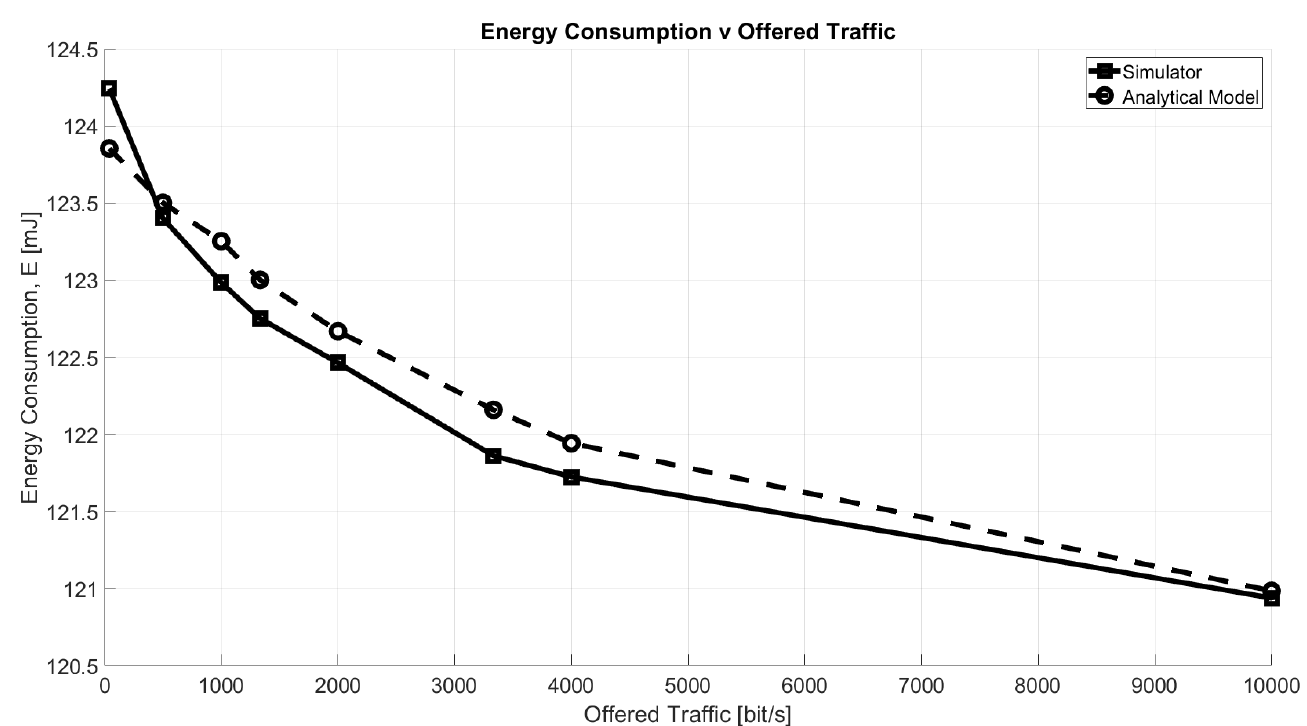
Figure 6. Energy consumption as a function of offered traffic,